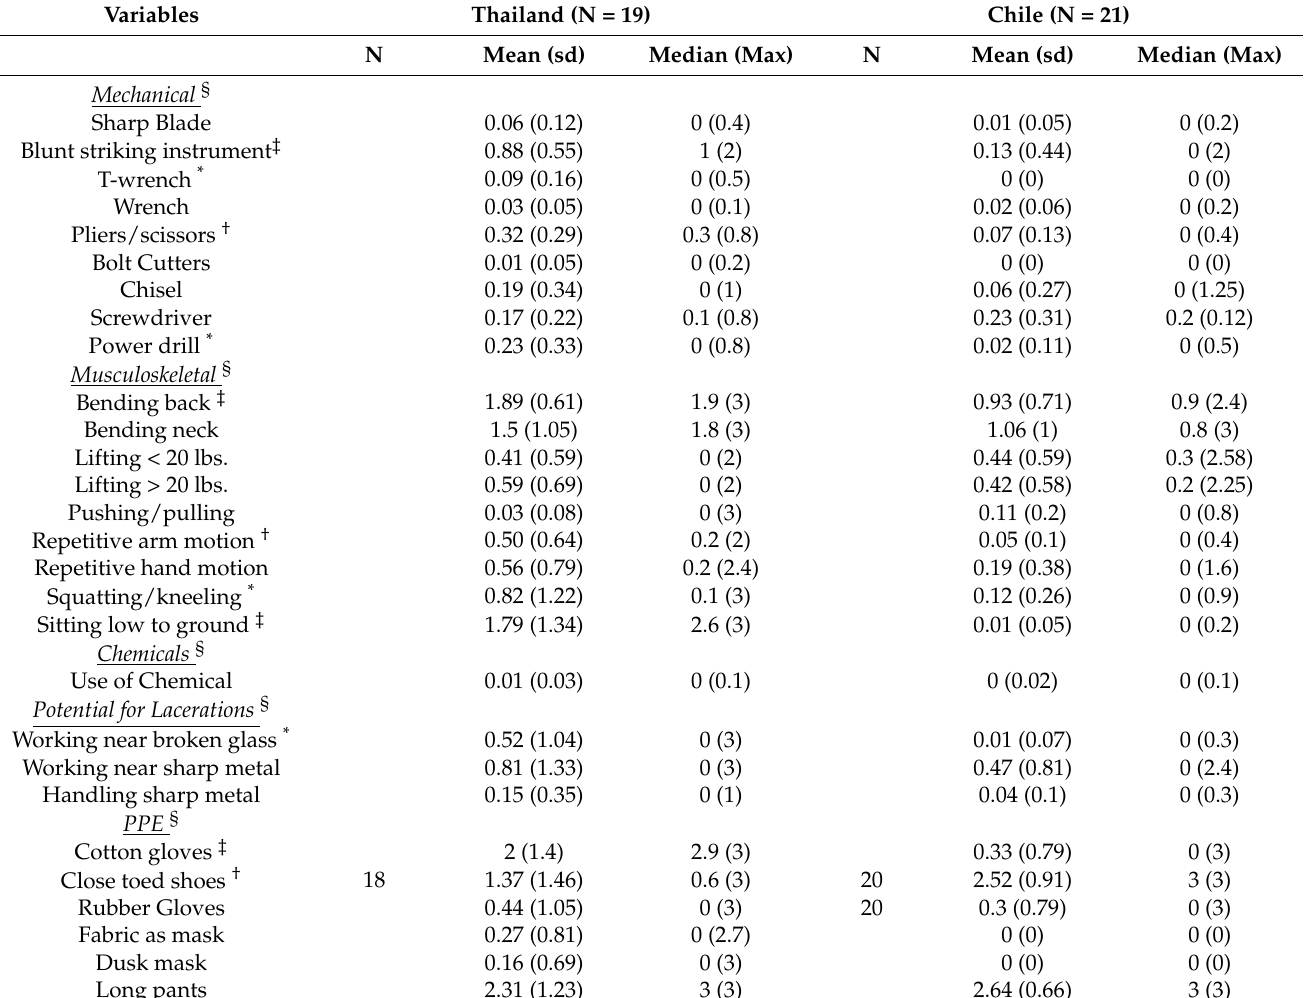
Table 4. Job characteristics of Thai and Chilean e-waste recycling workers with video